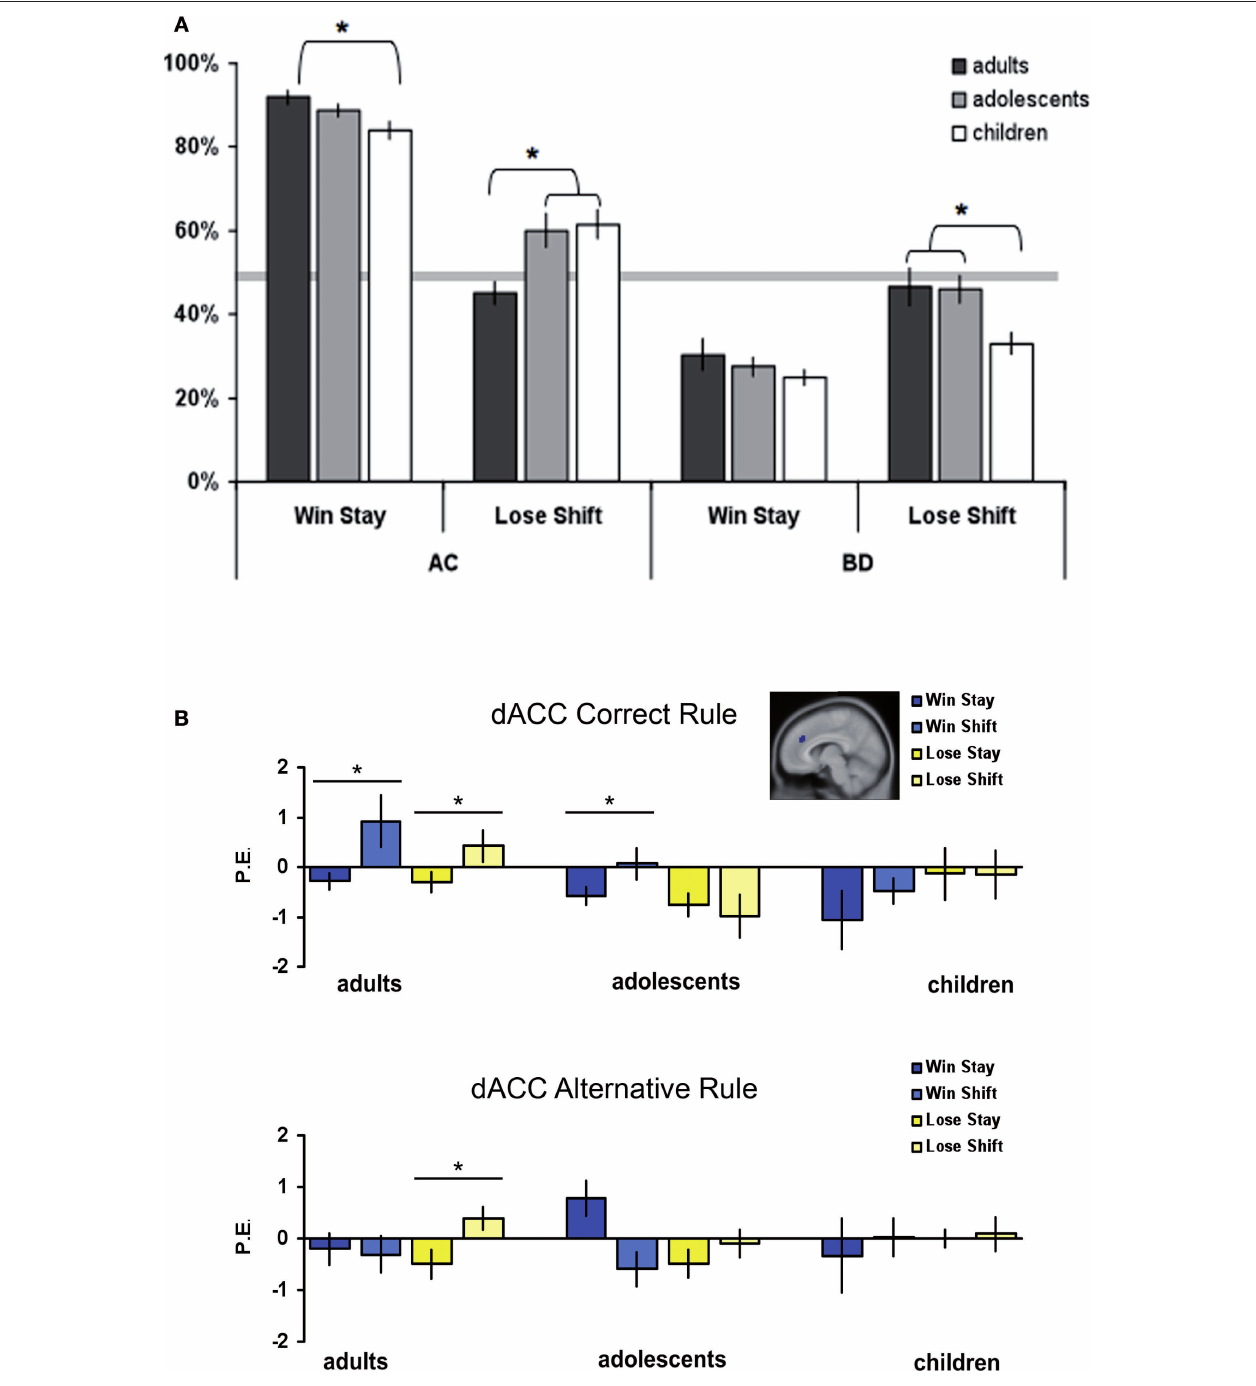
or shifting, displayed for each age group and rule type separately. Signifi cant differences between brain activity in two conditions are indicated with an asterisk (*Bonferroni